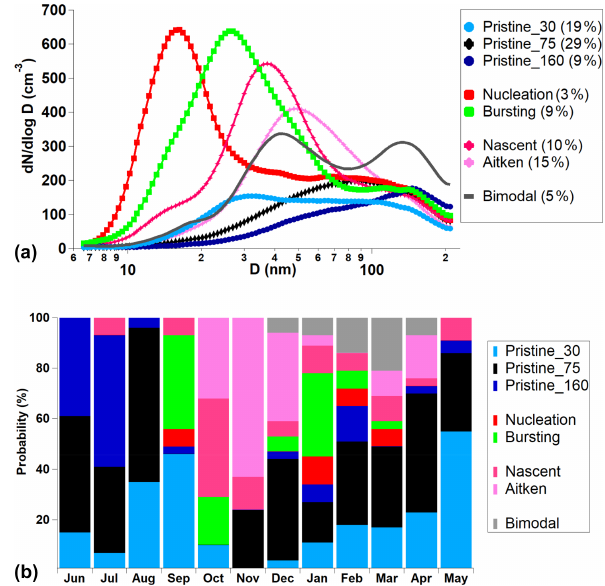
Figure 2. (a) Size distribution of the eight k -mean clusters and (b) annual frequency distributions of the six aerosol categories. D: